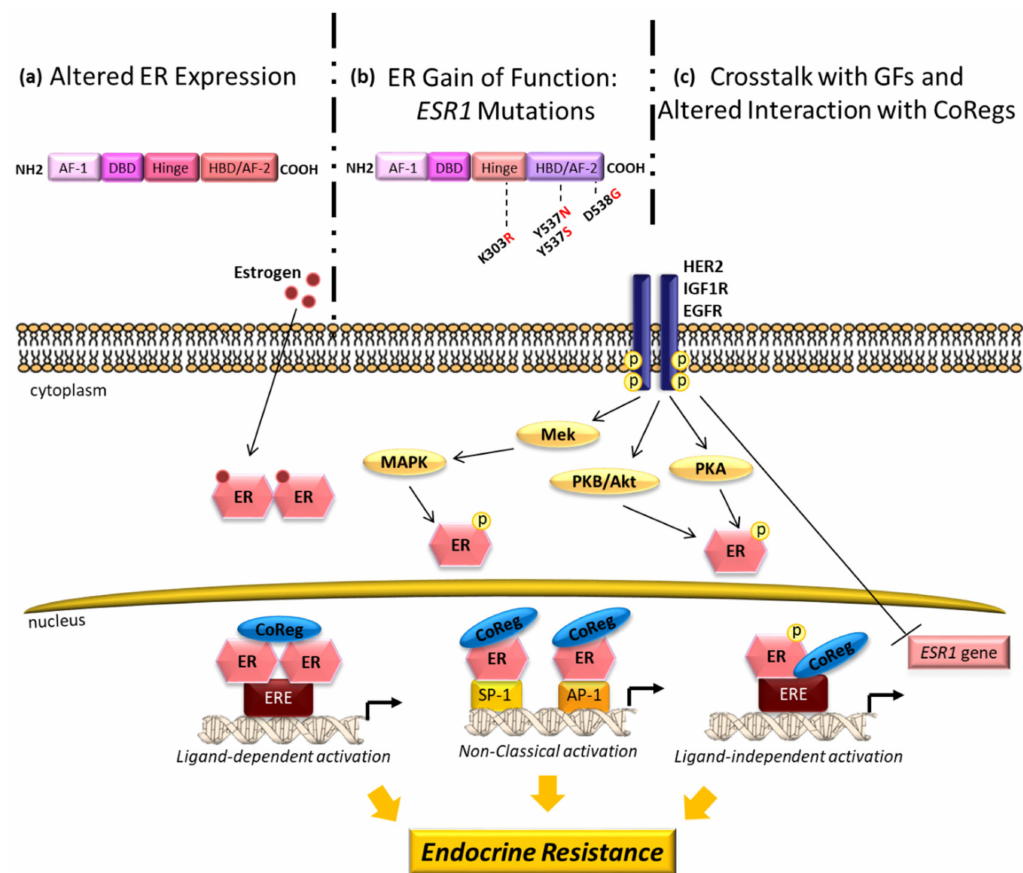
Figure 1. Representation of the main mechanisms sustaining endocrine resistance mediated by estrogen receptor α (ER α ). The structural domains of ER α contain the ligand-independent activation function (AF-1) in the amino-terminal region, a DNA-binding domain (DBD), and a carboxy-terminal hormone-binding domain (HBD), containing the ligand-dependent activation function (AF-2). In the classical ER α activation, estradiol binds to its cognate receptor in the cytoplasm, leading to dimerization, nuclear translocation and interaction with specific DNA sequences (ERE, estrogen responsive element) in